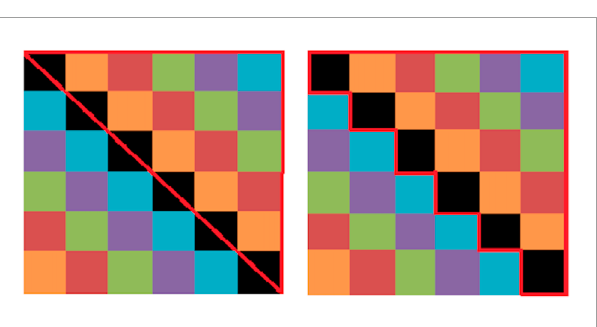
FIGURE 3 The parallel calculation process of matrix multiplication, six kinds of color matrices represent the parallel calculation process for simplifying. The left figure shows the block diagonal matrices in the same color are calculated step by step after exchanging the data in Figure 2 . The right one shows that the part of the red line box is calculated based on the symmetrical feature of normal equations in gravity field